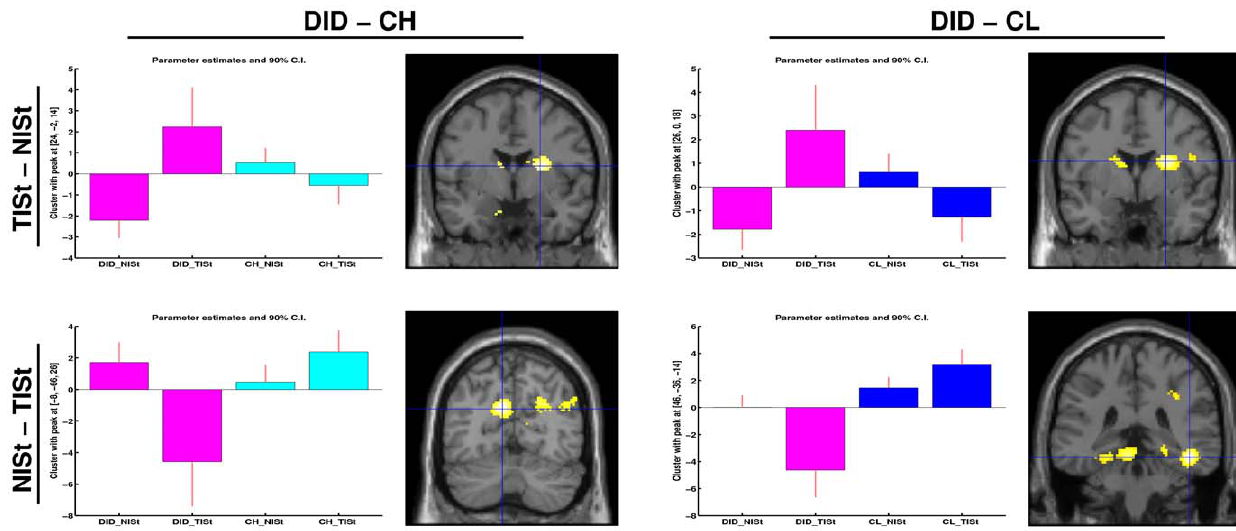
Figure 6. The brain areas indicated with the blue cross (i.e. the peak voxel) are (from top left to bottom right): the right caudate nucleus (dorsal part) (2x), the left precuneus, and the right occipitotemporal sulcus. These areas involve the most significant rCBF difference between the dissociative identity disorder patients and high and low fantasy prone DID simulating controls (CH and CL respectively) and is shown in both directionality, i.e. the bar graphs, and location, i.e. shown on a coronal overlay (left in the picture is left in the brain). Results show the differential processing of the trauma-related text between the TIS and the NIS, when comparing the DID groups to the high fantasy prone control group (left) and low fantasy prone control group (right).